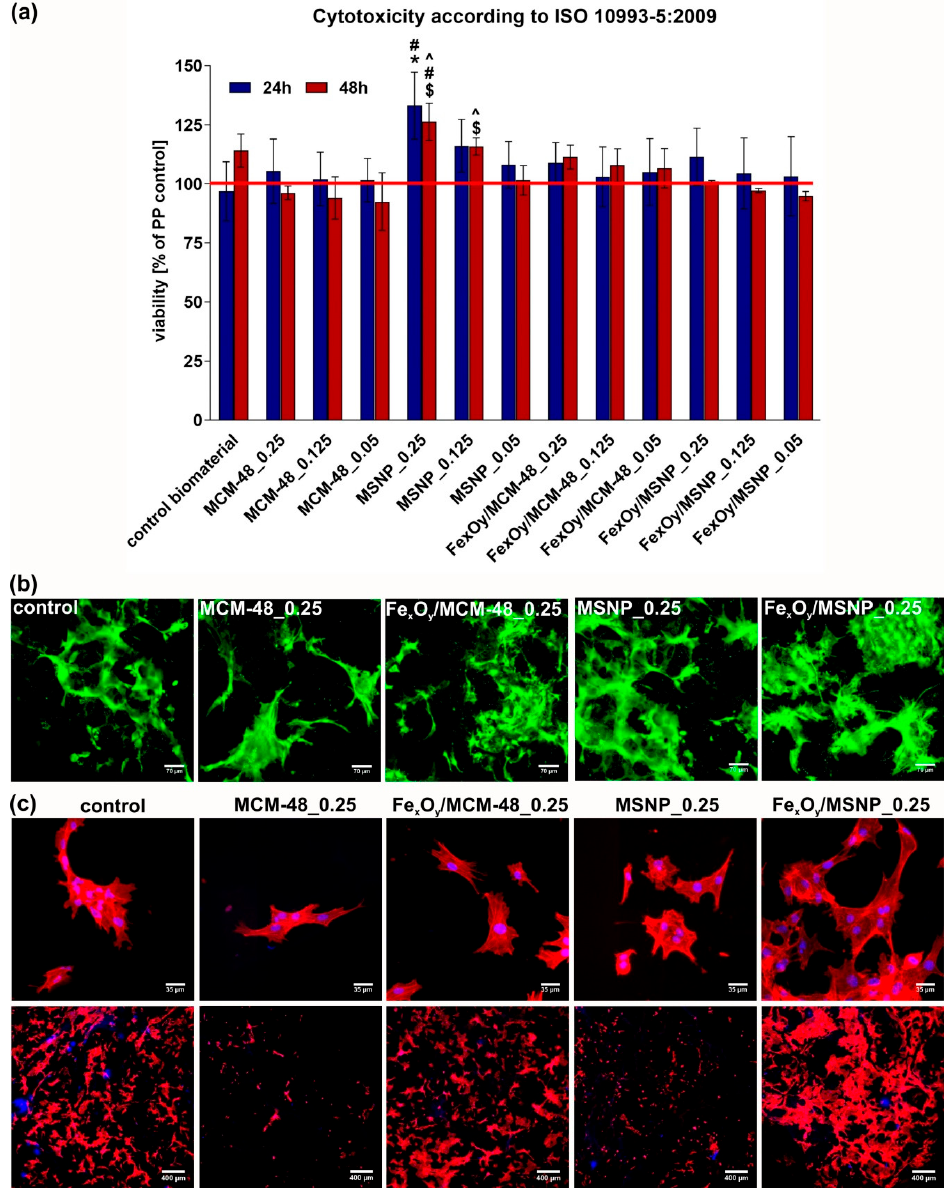
Figure 3. Biocompatibility screening tests on the NPs-loaded biomaterials: ( a ) MTT cytotoxicity test with the use of extracts of the biomaterials (PP control—cells exposed to the extract of polypropylene, revealing 100% viability; control biomaterial—extract of the biomaterial without any NPs; 0.25, 0.125, 0.05—concentration (wt.%) of NPs within the structure of the biomaterial; * statistically significant differences compared to the control biomaterial, # compared to the biomaterial containing Fe x O y /MCM-48 at corresponding concentration; $ compared to the biomaterial containing MCM at a corresponding concentration, and ^ compared to the biomaterial containing Fe x O y /MSNPs at a corresponding concentration, according to One-way Anova followed by Tukey’s test, p < 0.05); ( b ) CLSM images of 3-day culture of preosteoblasts (MC3T3-E1 cells at high concentration were seeded) on the surface of the biomaterials upon fluorescent live/dead staining (control—biomaterial without any NPs; 0.25—concentration (wt.%) of NPs within the structure of the biomaterial; green fluorescence—viable cells, red fluorescence—nuclei of dead cells, magn. 200 × ); ( c ) CLSM images of 3-day culture of preosteoblasts (MC3T3-E1 cells at low concentration were seeded) on the surface of the biomaterials upon fluorescent staining of cytoskeleton and nuclei (red fluorescence—cytoskeleton, blue fluorescence—nuclei, upper images—magn. 400 × , lower images—magn. 40 ×